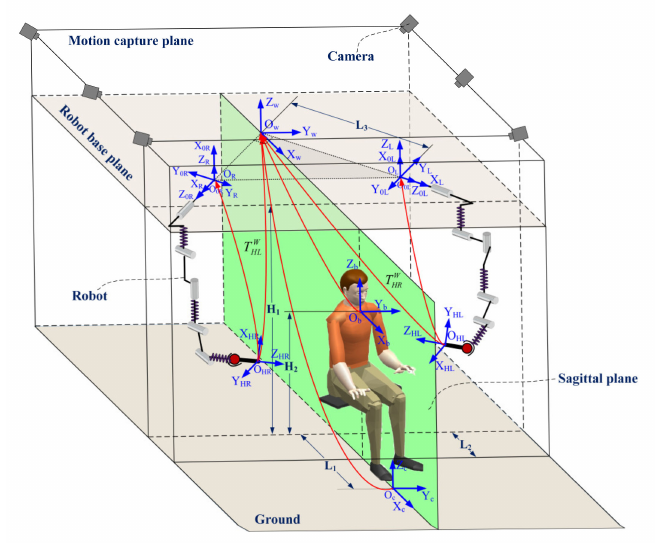
Figure 3. The schematic diagram of the coordinate frames